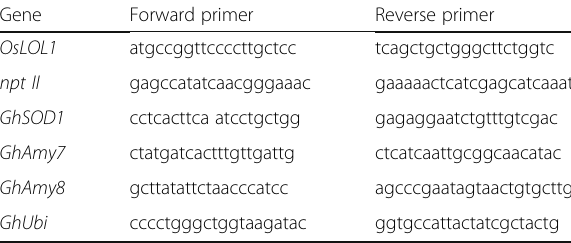
Table 2 The primers used in PCR analysis